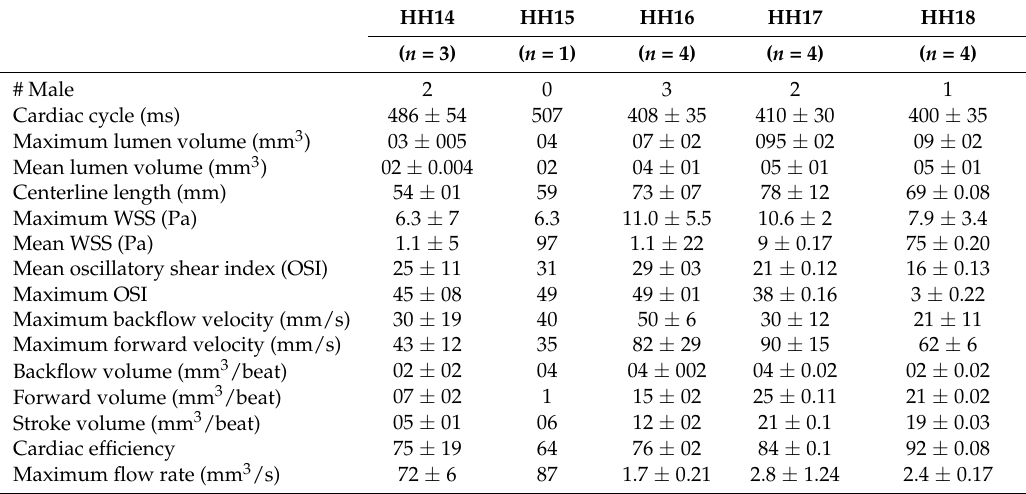
Table 1. A summary of the heart outflow tract hemodynamic results. The values are presented as the mean plus or minus the standard